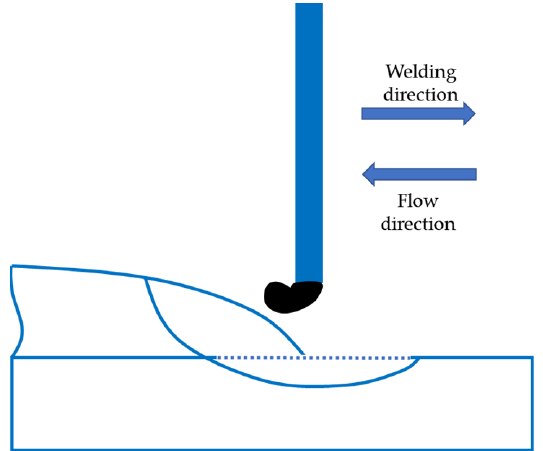
Figure 17. Movement of droplets during molten weld metal transport [8]. Reprinted with permission from Ref. [8]. 2022, Elsevier.